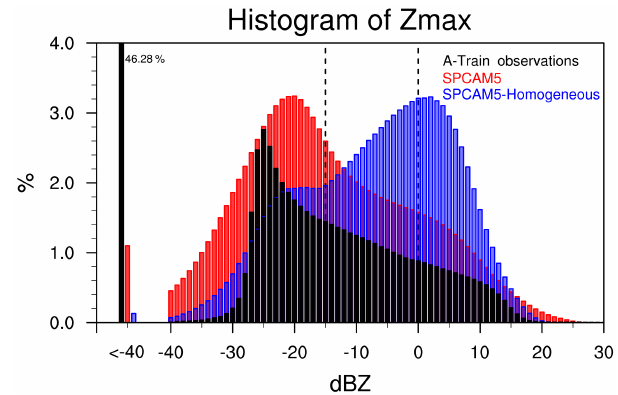
Figure 4. The histograms of column maximum radar reflectiv- ity for liquid clouds over oceanic regions from 45 ◦ S to 45 ◦ N in A-Train satellite observations, SPCAM5 COSP, and SPCAM5- Homogeneous COSP